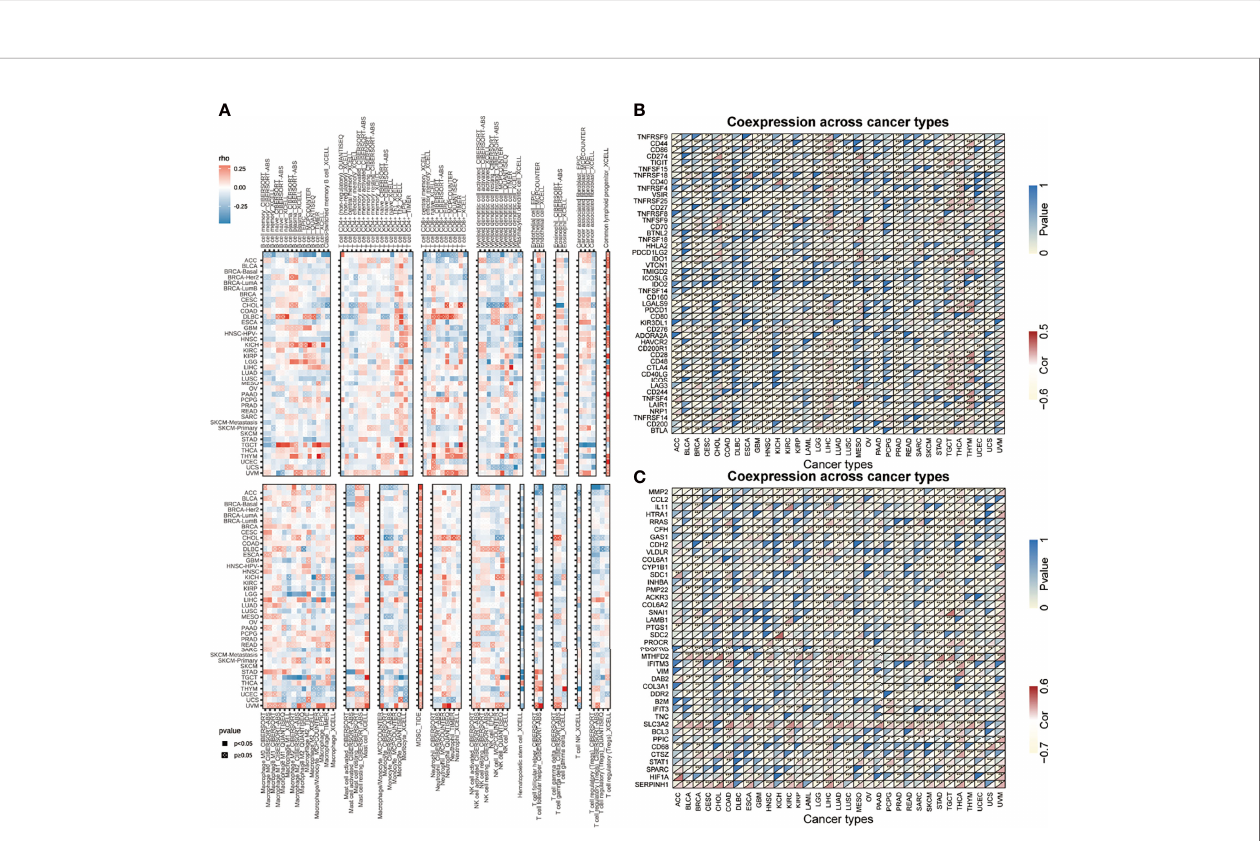
FIGURE 3 | Correlation analysis between the expression of AHSA1 and immune cell in fi ltration, checkpoint inhibitors and pyroptosis-related molecules. (A) Correlation analysis between AHSA1 and immune cell in fi ltration in pan-cancer. (B) Correlation analysis between the expression of AHSA1 and immune checkpoint inhibitors. (C) Coexpression analysis of AHSA1 expression and epithelial-mesenchymal transition-related molecules. *p< 0.05; **p<0.01;